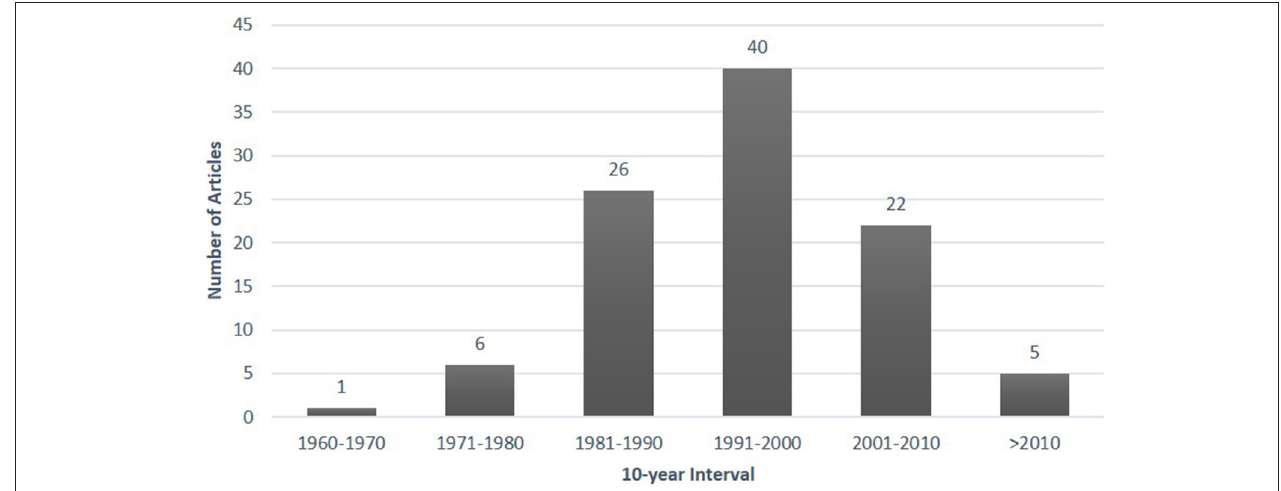
FIGURE 1 | The 100 top-cited articles on hematopoietic stem cell transplantation by 10-year